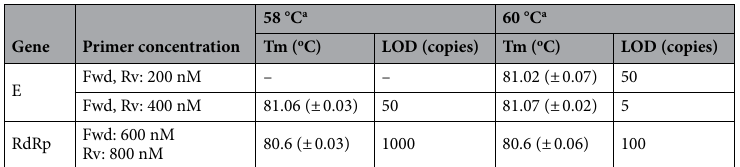
Table 1. Performance of primers of the intercalating dye-based RT-qPCR protocol for SARS-CoV-2 detection. Fwd: forward primer; Rev: reverse primer; Tm: melting temperature; LOD: limit of detection. a Primer annealing